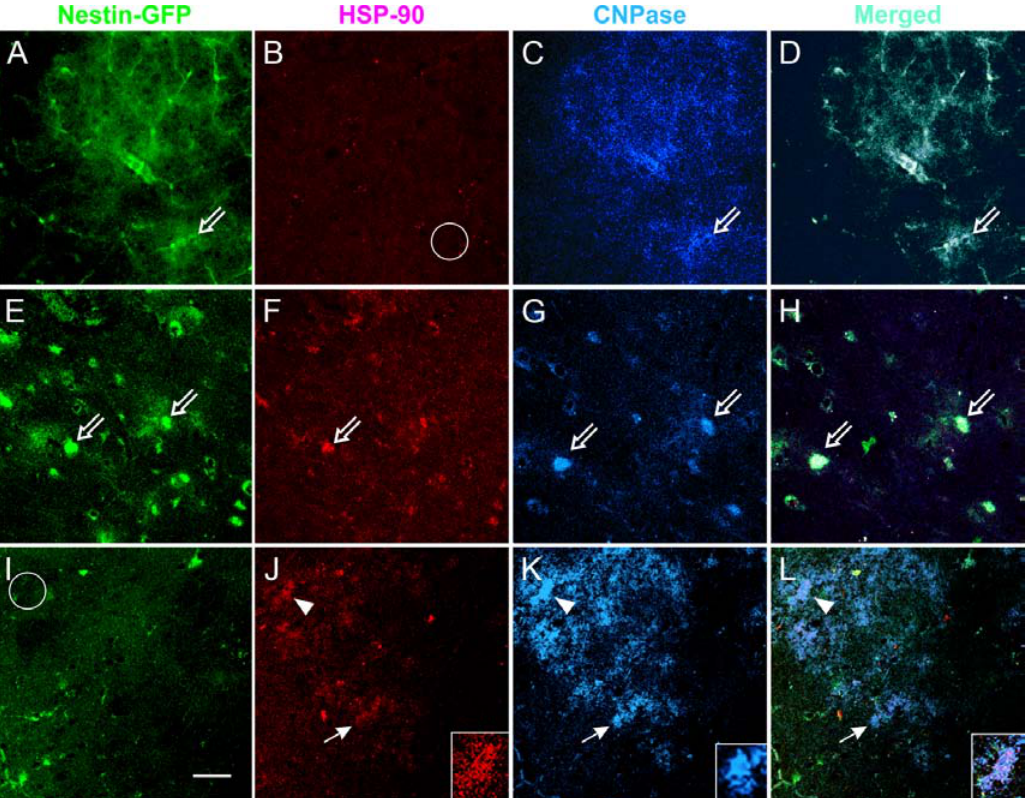
non-treated slices. In contrast, HSP-90 was expressed as “puncta” mainly along myelin tracks. Some OLs recognized by CNPase co-expressed HSP-90 in NMDA treated slices. Slices pre-incubated in TSC1 had HSP-90 expressing cells that co-expressed CNPase, but the myelin tracks were not labeled by the stress protein, suggesting neuroprotection through TSC1 (Figure 7). Figure 7. Acute NMDA elicits the expression of HSP-90 in the CPu and TSC1 neutralizes the NMDA effect. Views of the CPu of 300 μm coronal slices used for the acute treatment of NMDA alone or in slices pre-incubated with TSC1. After electrophysiology, slices were fixed and immunolabeled for the cell stress marker HSP-90 and the OL marker CNPase. HSP-90 was expressed in some cells located in the CPu white matter. Non-treated slices ( A – D ) displayed nestin-expressing cells that were negative for HSP-90 ( B - empty circle ). Slices directly exposed to NMDA ( E – H ); showed colocalization of nestin and HSP-90 ( E , F ) and few cells co-express the three markers ( open arrows ). CNP-expressing cells lost processes or expression of CNPase in their processes. Slices incubated with TSC1 prior to NMDA. TSC1 appeared to maintain the tissue in a mild stage of stress with fewer nestin-expressing cells co-expressing HSP-90 (panel I ) and increased number of CNPase-positive OL ( K ). Arrowheads show cells co-expressing HSP-90 and CNPase ( K ). Insets show detail of the label distribution of the cell marked with arrowheads, the merged view allows for the visualization of HSP-90 in the cell soma while CNPase is distributed in the cell body and numerous cell processes ( L ). K -inset shows a healthy OL that did not express HSP-90 ( I - circle